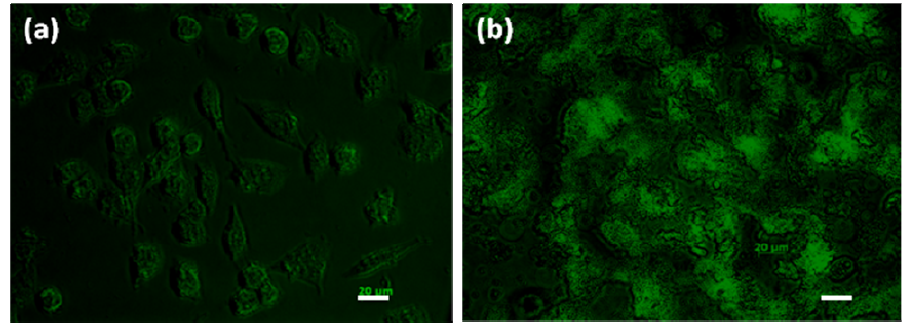
Figure 9. Cellular uptake of polystyrene/PNIPAAm core-silica shell nanoparticles by PC3-PSMA prostate cancer cells at low (a) or high (b) nanoparticle dosage. Scale